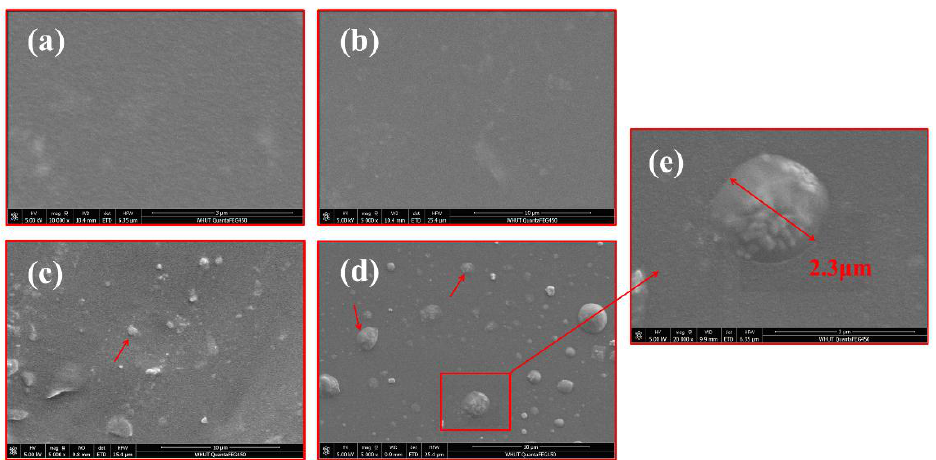
Figure 8. SEM-derived morphology for the different asphalt binders: ( a ) aged binder (5000×); ( b ) CR rejuvenated binder (5000×); ( c ) MR-1 rejuvenated binder (5000×); ( d ) MR-2 rejuvenated binder (5000×); ( e ) MR-2 rejuvenated binder enlarged (20,000×).